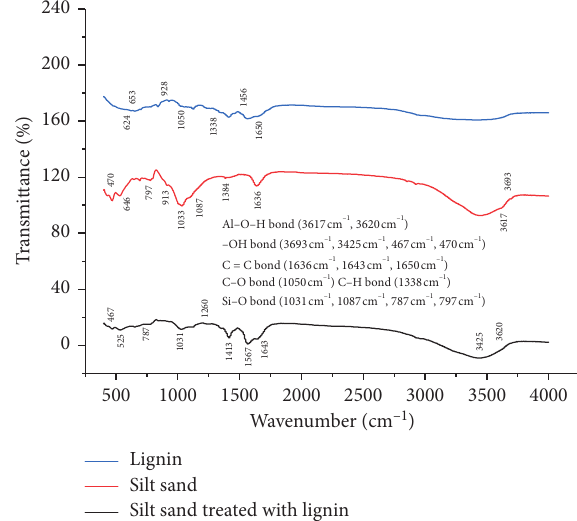
Figure 13: EDS analysis of silt sand and silt sand treated with lignin.